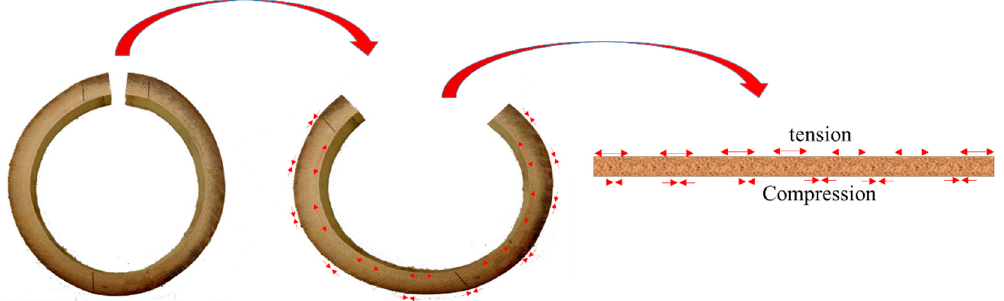
Figure 7. The mechanism of flattening.